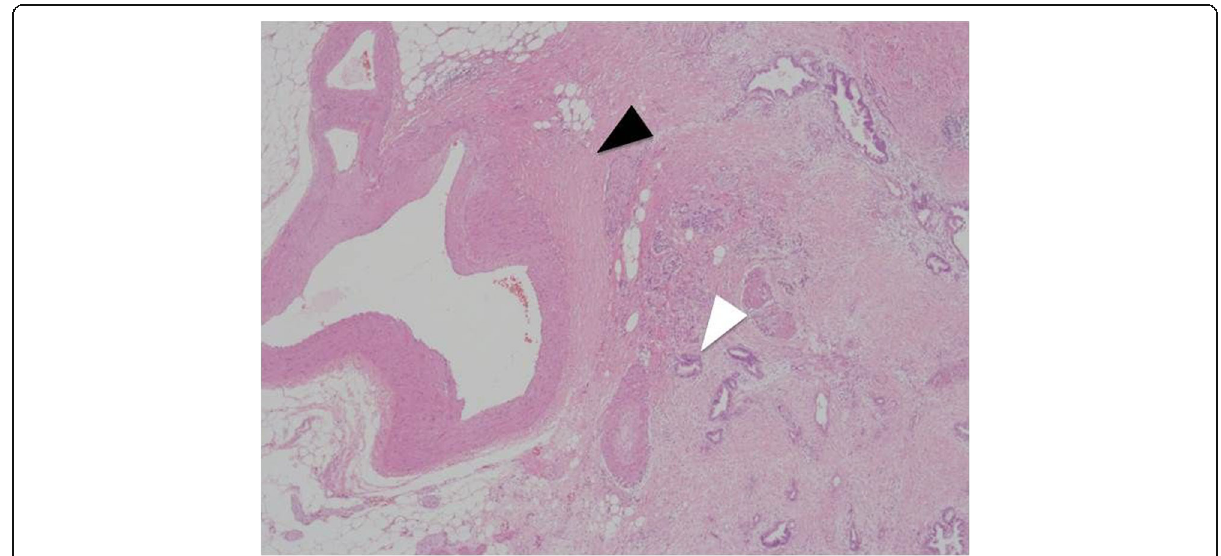
Fig. 3 The pathological examination revealed that the tumor ( white arrow head ) invasion was seen near the intraparenchymal vessels ( black arrow head